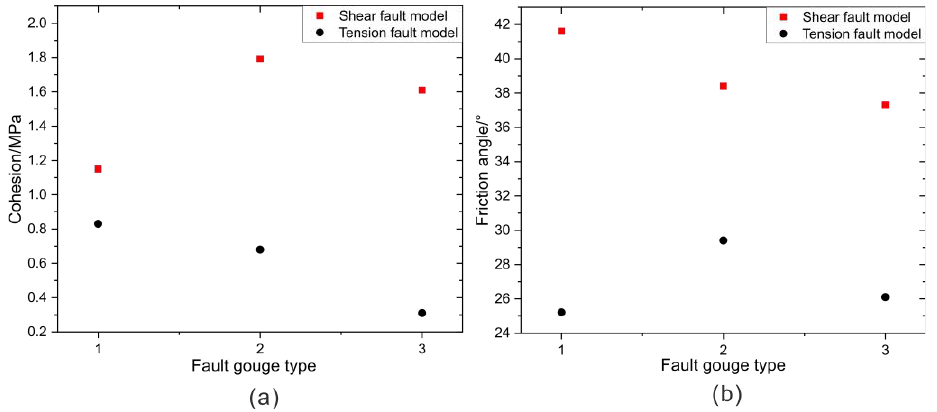
Figure 15. Effect of fault gouge type on cohesion and friction angle. ( a ) is the relationship between cohesion and fault gouge type; ( b ) is the relationship between friction angle and fault gouge type.